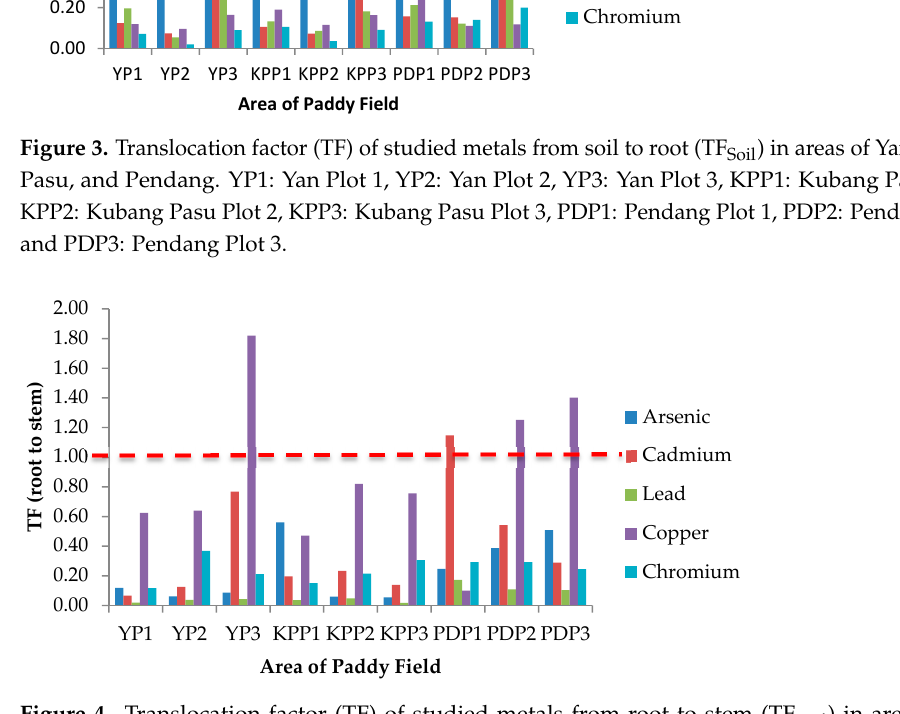
Figure 4. Translocation factor (TF) of studied metals from root to stem (TF root ) in areas of Yan, Kubang Pasu, and Pendang. YP1: Yan Plot 1, YP2: Yan Plot 2, YP3: Yan Plot 3, KPP1: Kubang Pasu Plot 1, KPP2: Kubang Pasu Plot 2, KPP3: Kubang Pasu Plot 3, PDP1: Pendang Plot 1, PDP2: Pendang Plot 2, and PDP3: Pendang Plot 3.